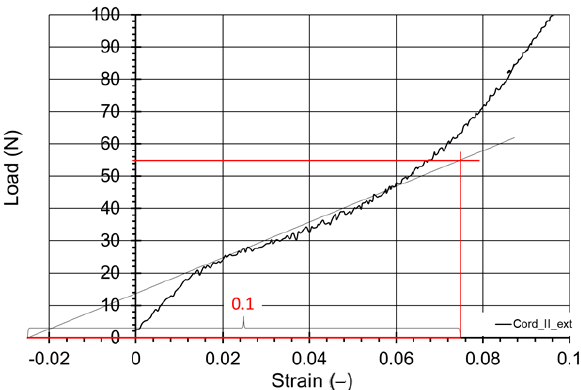
Figure 10. Example of initial modulus calculation for Cord II tested using videoextensometer.